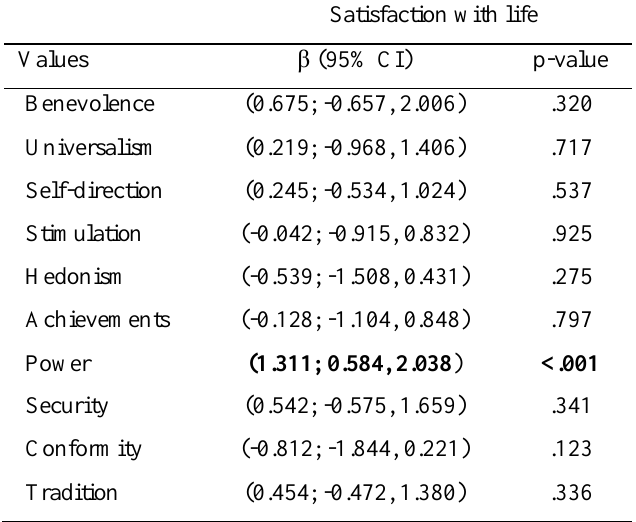
Association between satisfaction with life and values Satisfaction with